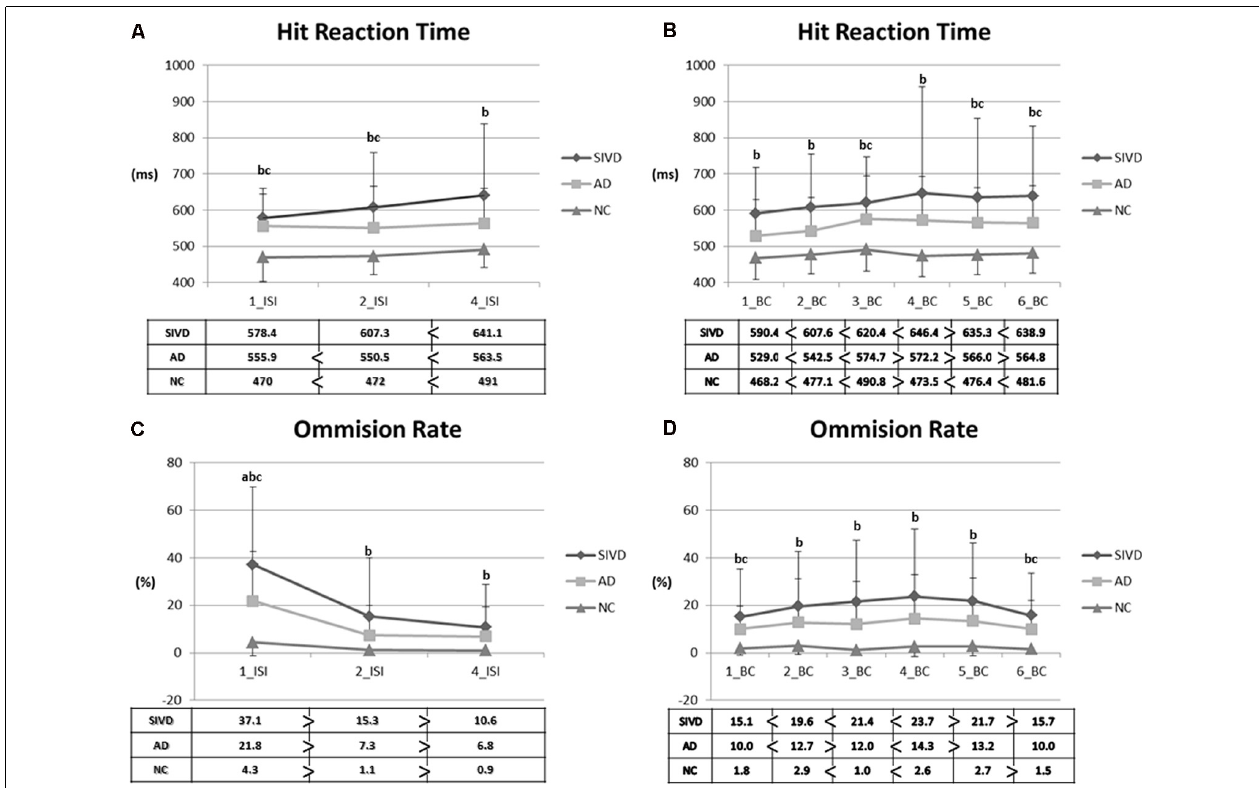
FIGURE 1 | Parameters representing vigilance and sustained attention. (A) Hit reaction time (HRT) across interstimulus intervals. (B) HRT across blocks. (C) Omission rate across interstimulus intervals. (D) Omission rate across blocks. 1/2/4_ISI: 1/2/4_seconds_interstimulus interval; 1–6 block change (BC): 1st–6th BCs; SIVD, subcortical ischemic vascular disease; AD, Alzheimer’s disease; NC, normal cognition. Data presented as mean (SD). Comparisons were made by using the analysis of variance (ANOVA) and paired T -tests. P -values < 0.05 resulting from ANOVA post hoc Tukey analyses were as follows: a: between SIVD and AD; b: between SIVD and NC; c: between AD and NC.